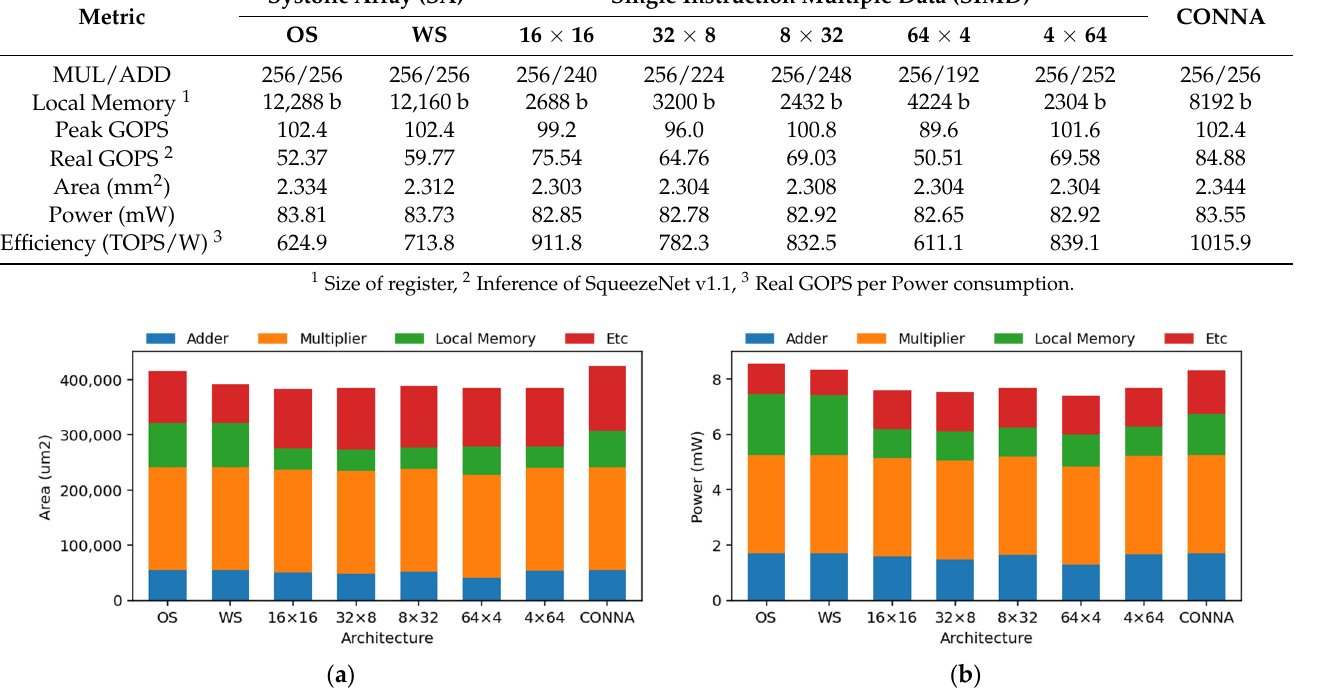
Figure 12. Detailed hardware implementation cost of each accelerator excluding the SRAM: ( a ) silicon area ( μ m 2 ); ( b ) power consumption (mW). Table 6. Summary of implementation evaluation on three types of neural network accelerators.